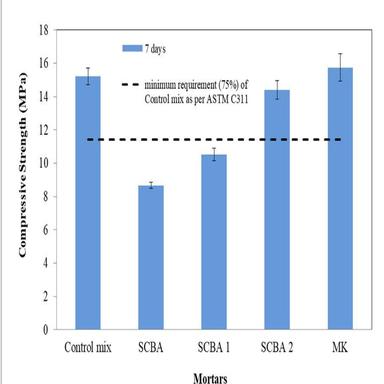
Compressive strength after 7 days of curing for SCBA samples and MK.